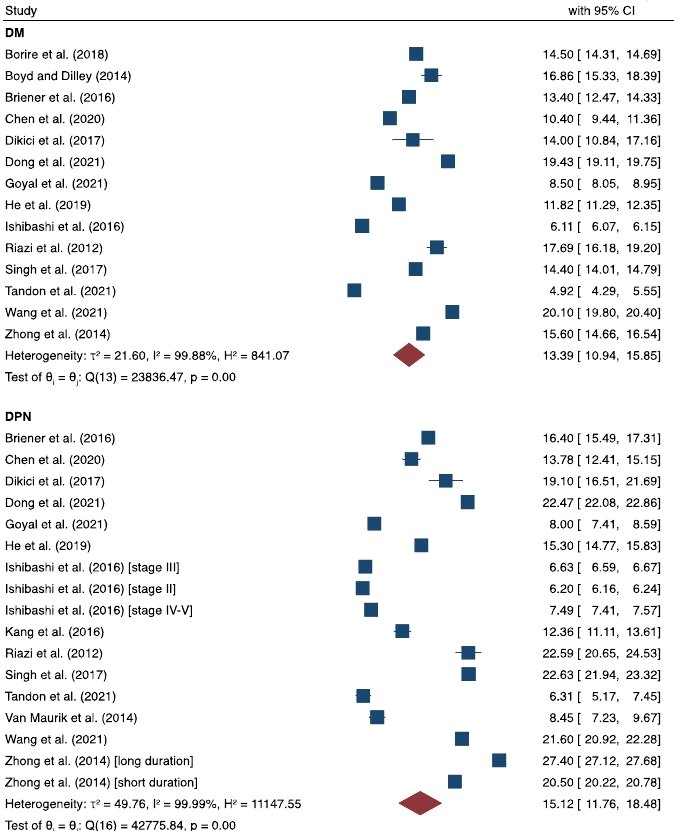
Figure 2. Forest plot showing the pooled tibial nerve cross-sectional area by subgroup. The squares indicate the cross-sectional area of each study. Size of each square is relative to the study’s